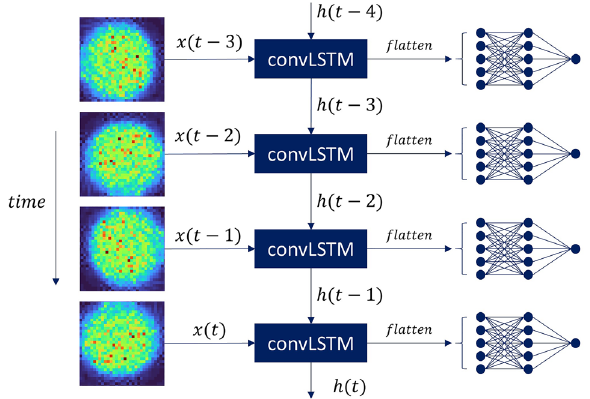
Figure 5. DNN classifier architecture. A visualization of the model in operation on a speckle input signal is shown. With state-to-state kernels of size 3 × 3, the ConvLSTM single layer network contains 64 hidden states and input-to-state for 64 input frames. Since the required model’s prediction is a binary classification task, we concatenated all forecasting network’s states and fed them into a 256-unit dense with ReLU activation, which speeds up our model’s training phase by reducing the gradient of the computational process. To produce the final prediction, we added a dense layer with two units on top of the